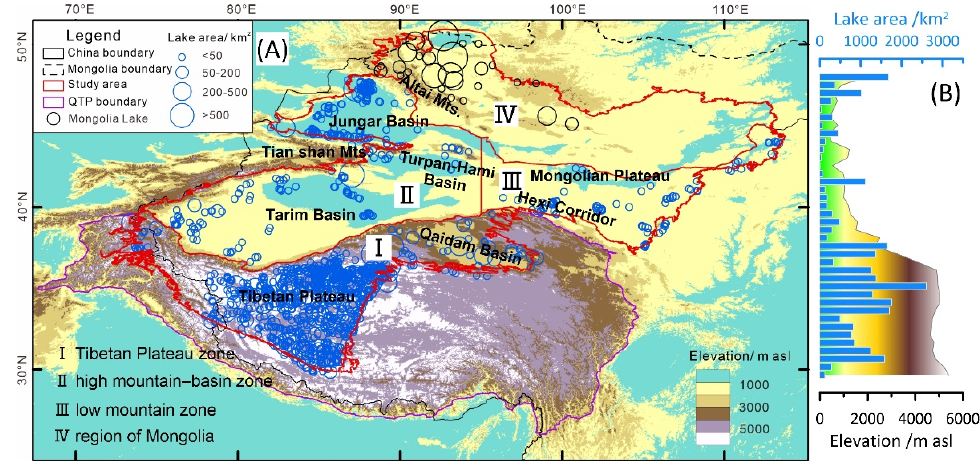
Figure 1. Lake distributions across CEA. ( A ) Spatial distribution of CEA lakes. Boundary of the Tibetan Plateau is from Zhang , et al. [22]; ( B ) Latitudinal distribution of lake area (0.5° latitude intervals); elevation background is the average elevation of lakes at 0.5° latitude spatial resolution.